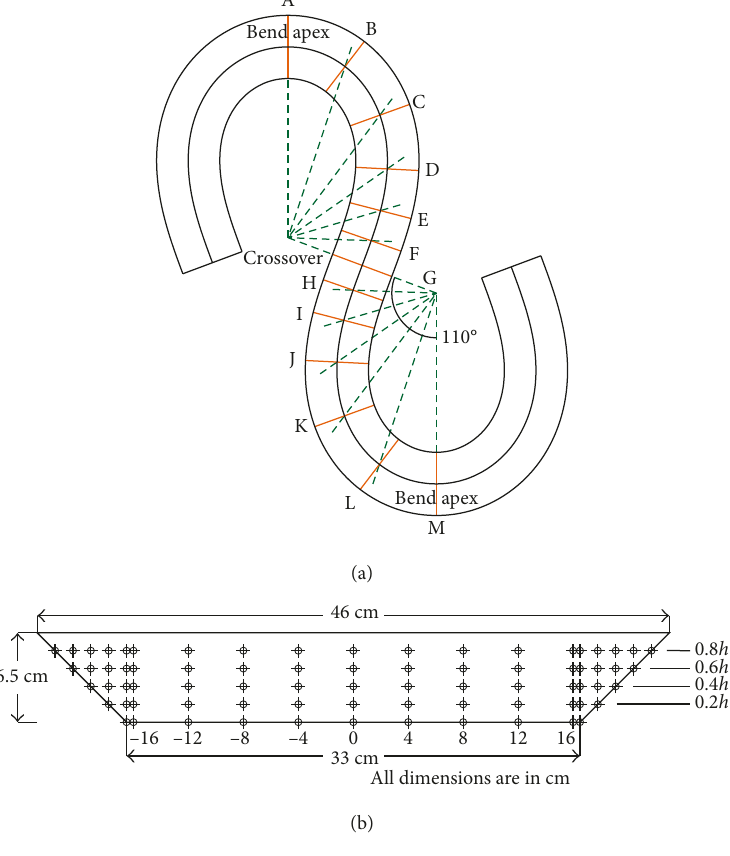
Figure 3: (a) Test section. (b) Position of